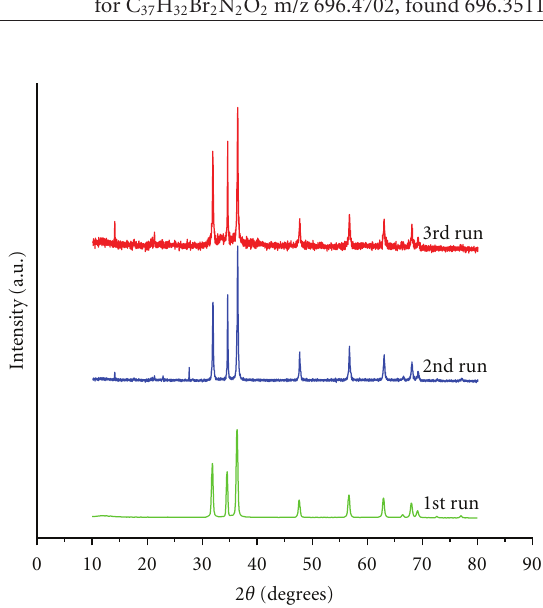
Figure 5: XRD spectrum of reutilized ZnO NPs.